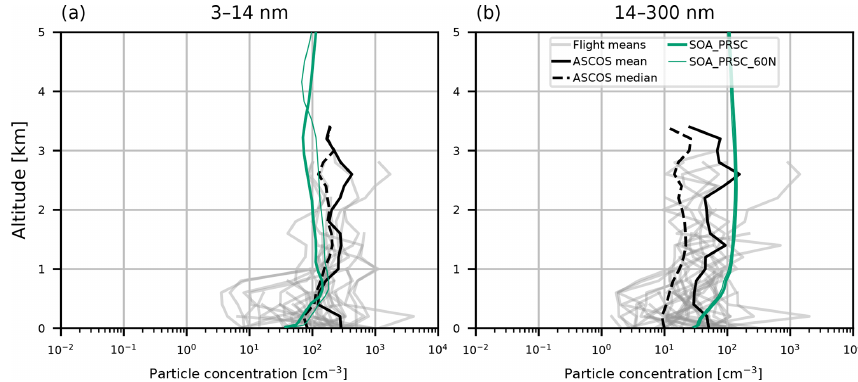
Figure D1. Aerosol vertical profiles from model output and ASCOS campaign observations. Model output is from collocated monthly mean values from simulations SOA_PRSC (thick dark green) and SOA_PRSC_60N (thin dark green). Observed values are given as the mean profile from each ASCOS flight (grey lines), overall mean (solid black), and overall median (dashed black). Profiles are for particles with size (a) 3–14nm, measured during ASCOS using a UCPC, and (b) 14–300nm, measured using a CPC (particles greater than 14nm) and a CLASP instrument (particles greater than 300nm).